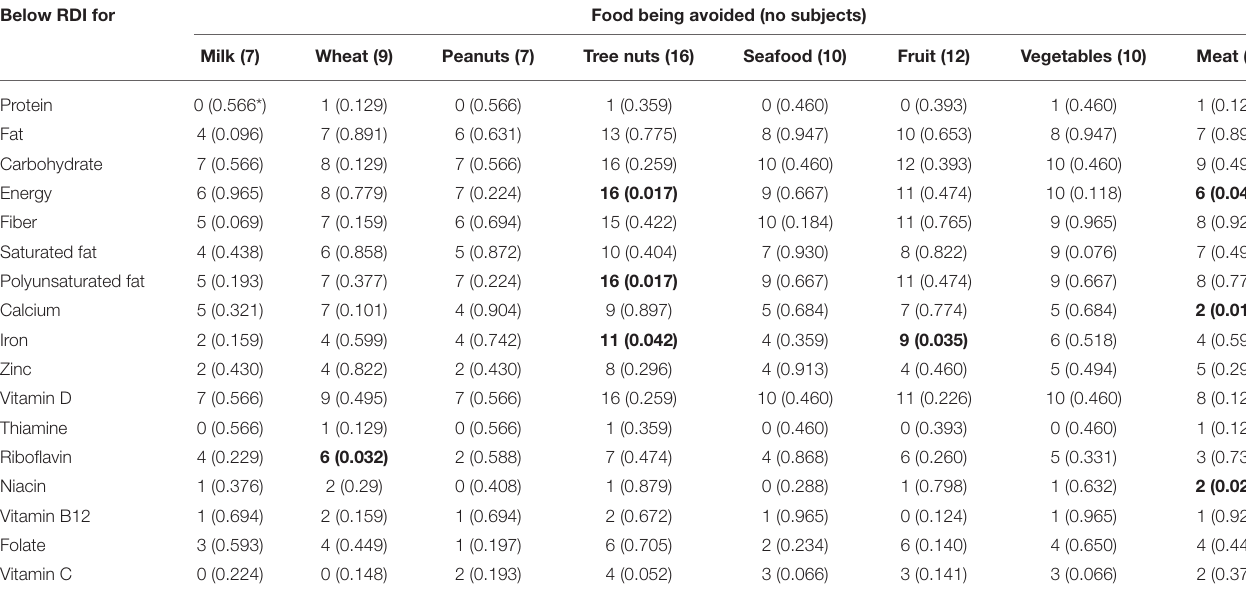
TABLE 4 | The number of patients avoiding a specific food who have intakes below the RDI for individual nutrients. Below RDI